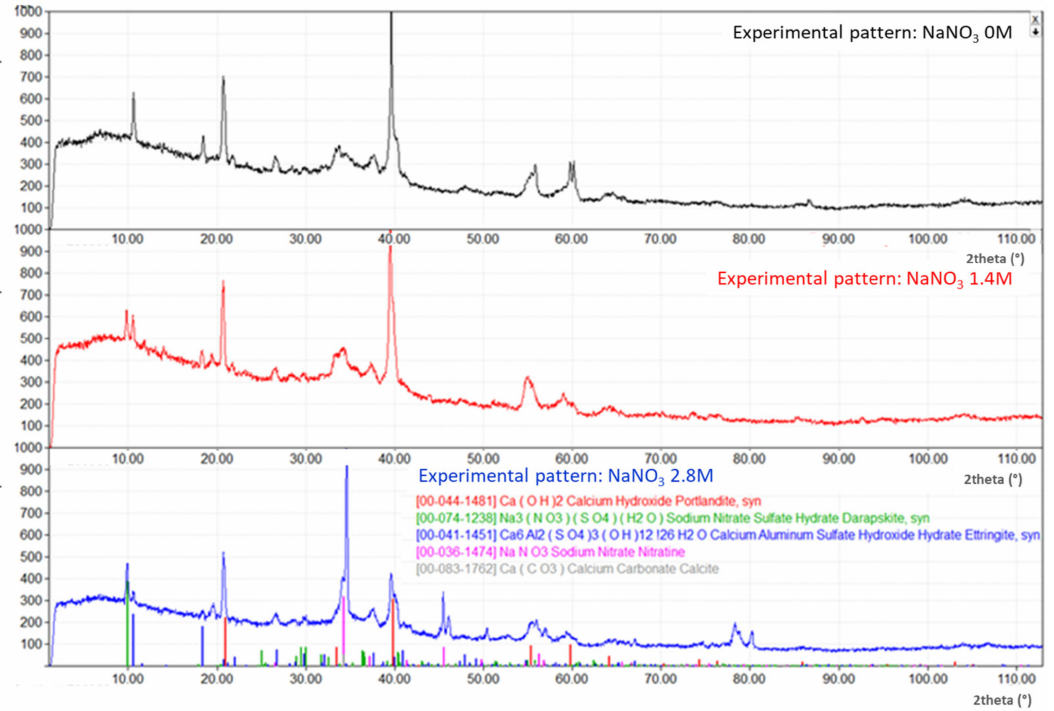
Figure 3. XRD patterns of CEM I HCP samples’ powder after 6 months of equilibration in NaNO 3 cementitious solutions.